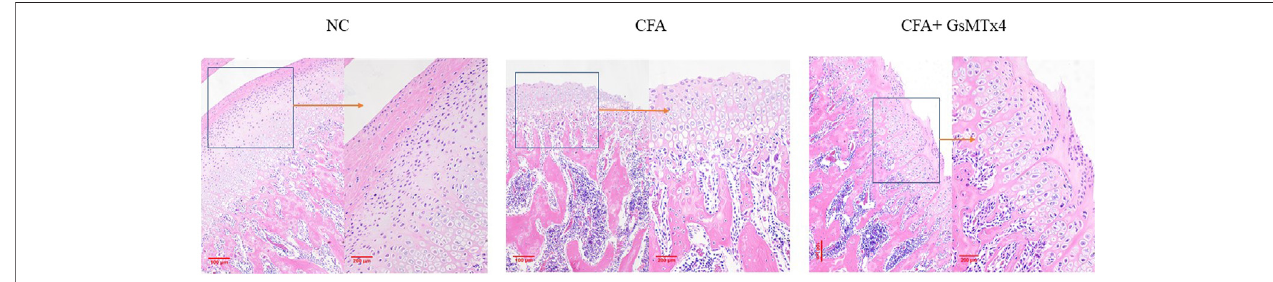
FIGURE 2 | NC: clear cell level; CFA: damage to the surface zone and value-added zone of the condylar cartilage layer and damage to the exposed subchondral bone with a partial hypertrophy zone; CFA + GsMTx4: damage to the surface zone and value-added